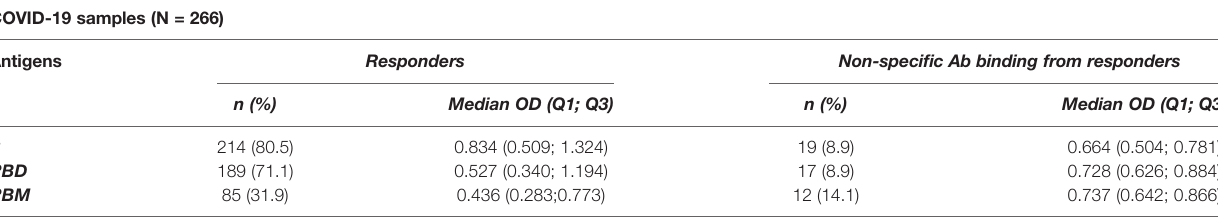
TABLE 3 | Proportion of non-speci fi c binding antibodies against S, RBD, and RBM responders in COVID-19 patients. COVID-19 samples (N = 266)